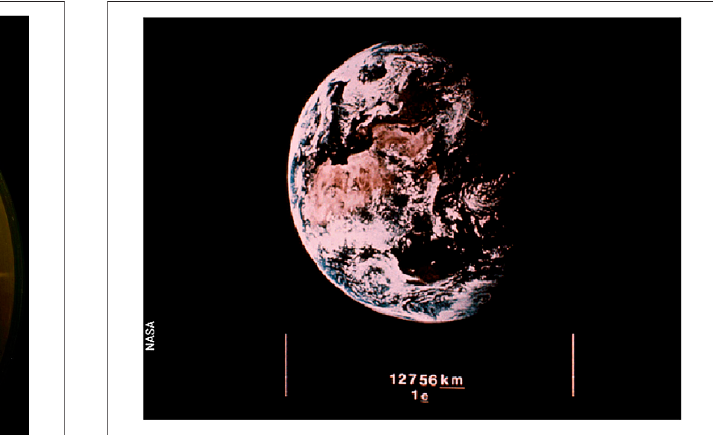
FIGURE 7 | Earth. Credit: NASA.